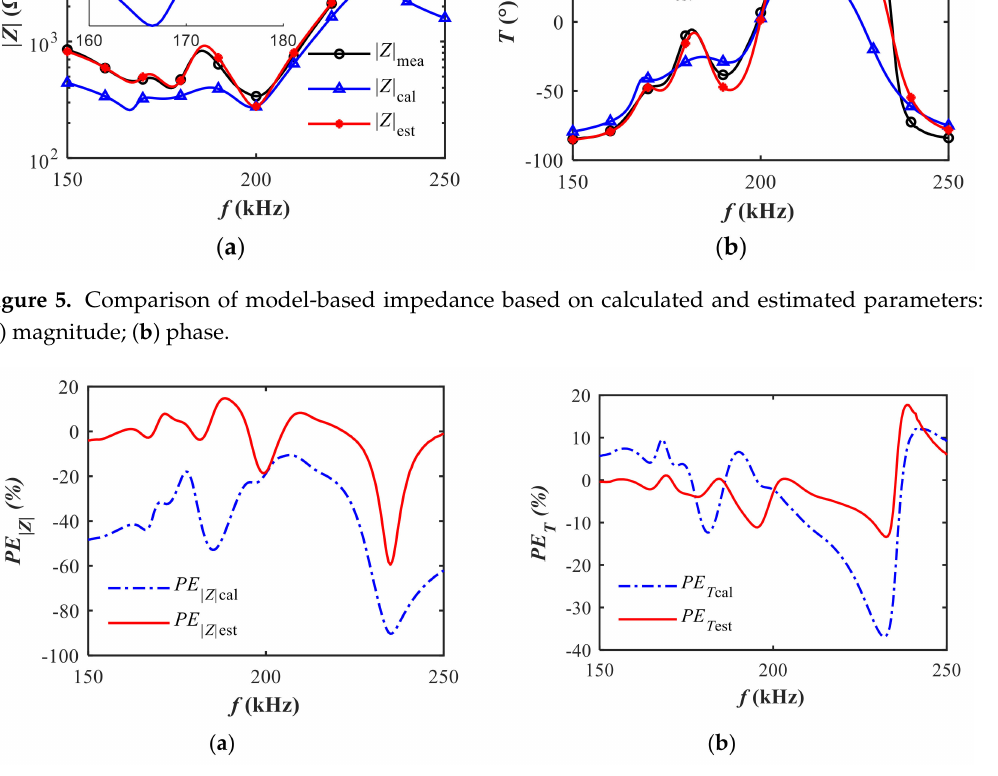
Figure 6. Comparison of percentage errors of impedance based on calculated and estimated parameters relative to the measurements: ( a ) magnitude; ( b )